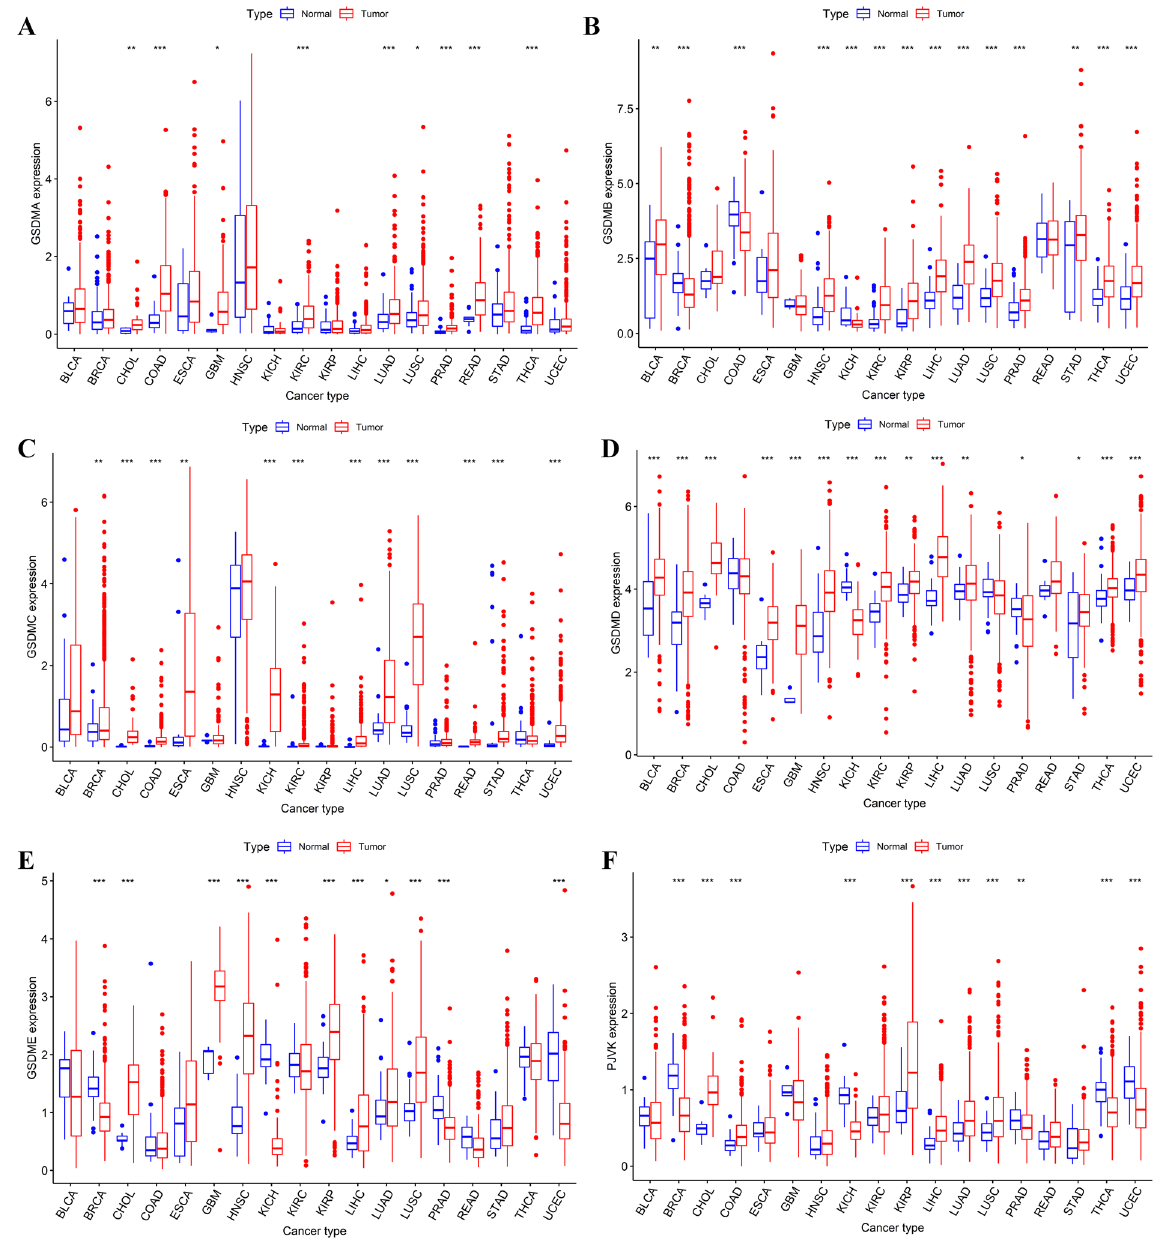
Figure 3. Comparisons of the gasdermin family gene expression levels between cancer and normal tissues from the TCGA database. The blue rectangle box represented genes expression levels in normal tissues, whereas the red rectangle box indicated gene expression levels in tumor tissues. P < 0.050, P < 0.010, and P < 0.001were denoted by “*”, “**”, and “***”, respectively. GSDMA ( A ), GSDMB ( B ), GSDMC ( C ), GSDMD ( D ), GSDME ( E ), and PJVK ( F ). The Y axis represented the gene expression level, and the unit was log2 (TPM +